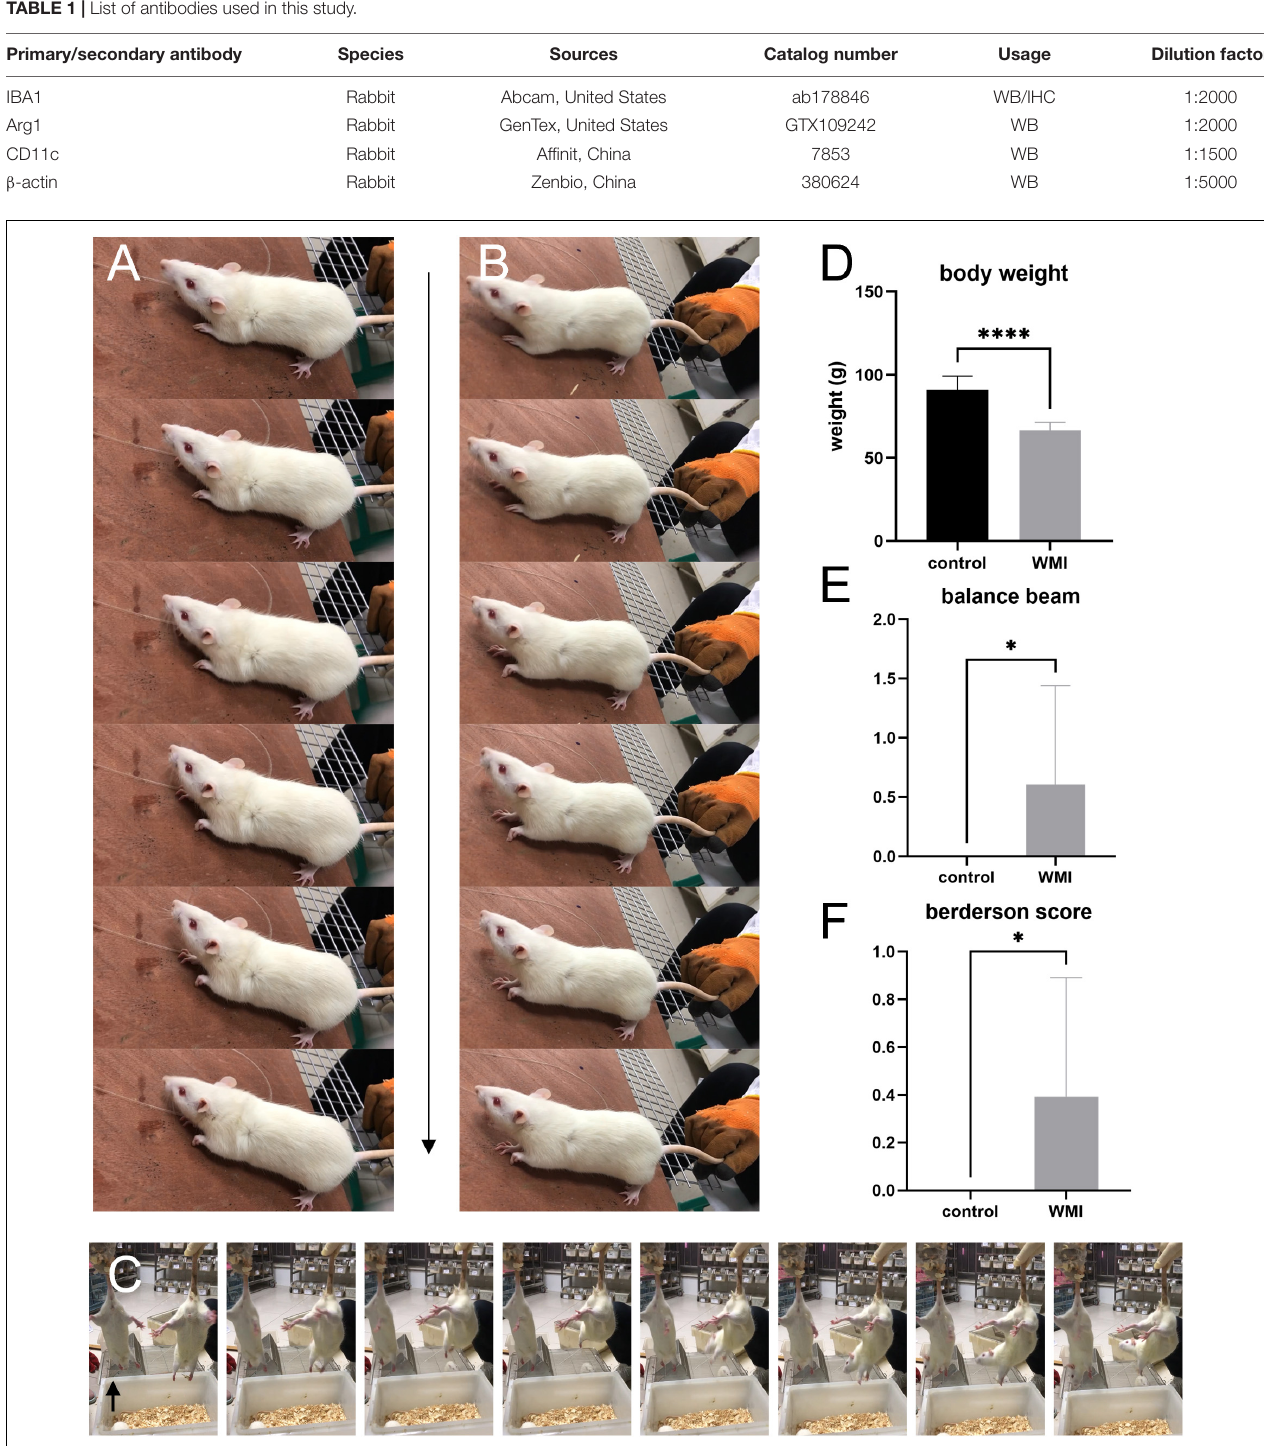
TABLE 1 | List of antibodies used in this study.